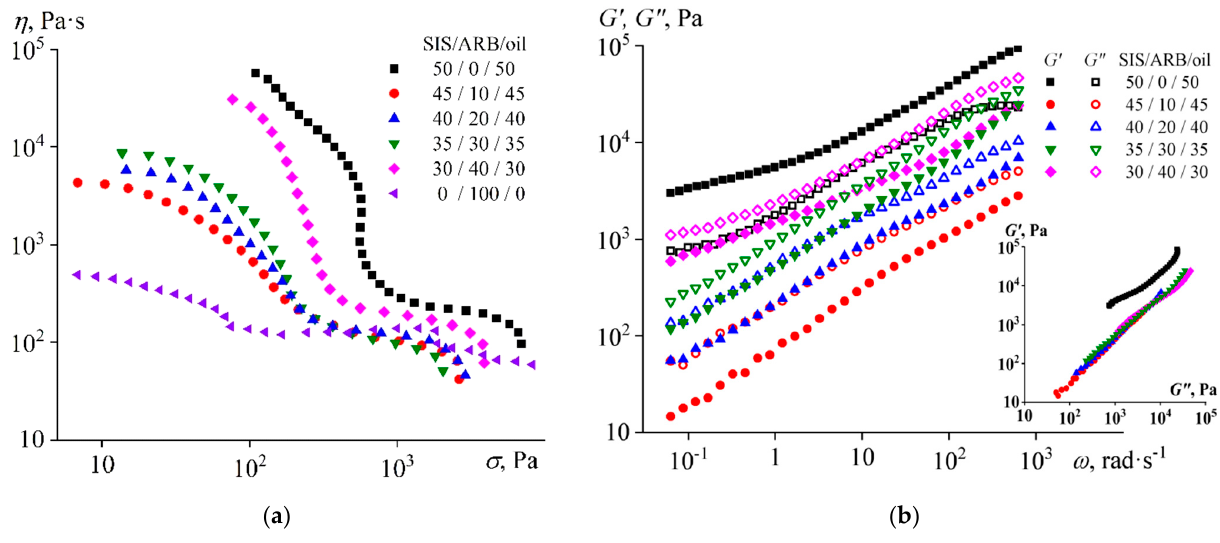
Figure 2. Flow curves ( a ) and frequency dependences of storage and loss moduli ( b ) for triple mixtures containing different concentration of asphaltene/resin blend (ARB) and an equal ratio between styrene ‐ isoprene ‐ styrene triblock copolymer (SIS) and naphthenic oil at 120 °C. The insert shows the Cole–Cole plots.